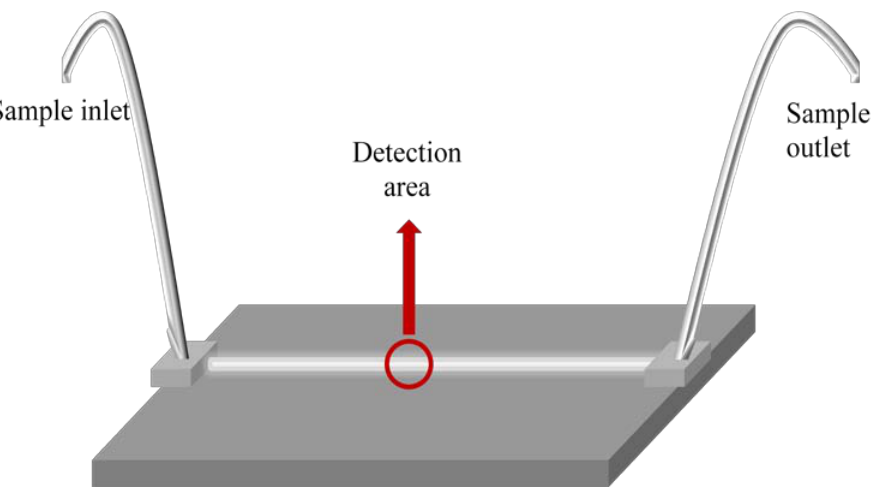
Figure 4. Schematic diagram of a single-flow immunosensor